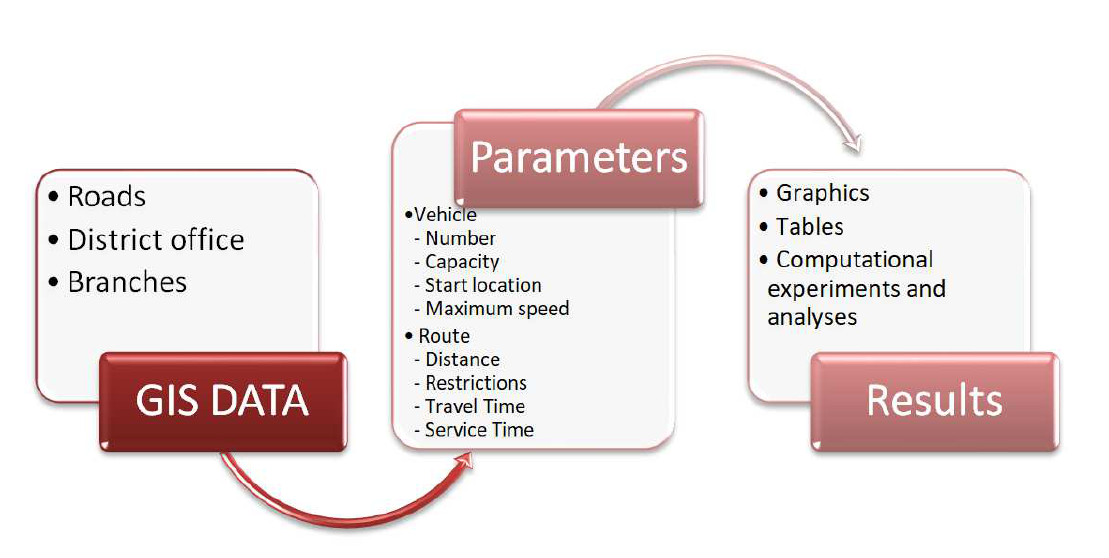
Figure 2. The framework of the system proposed in a form of a diagram.